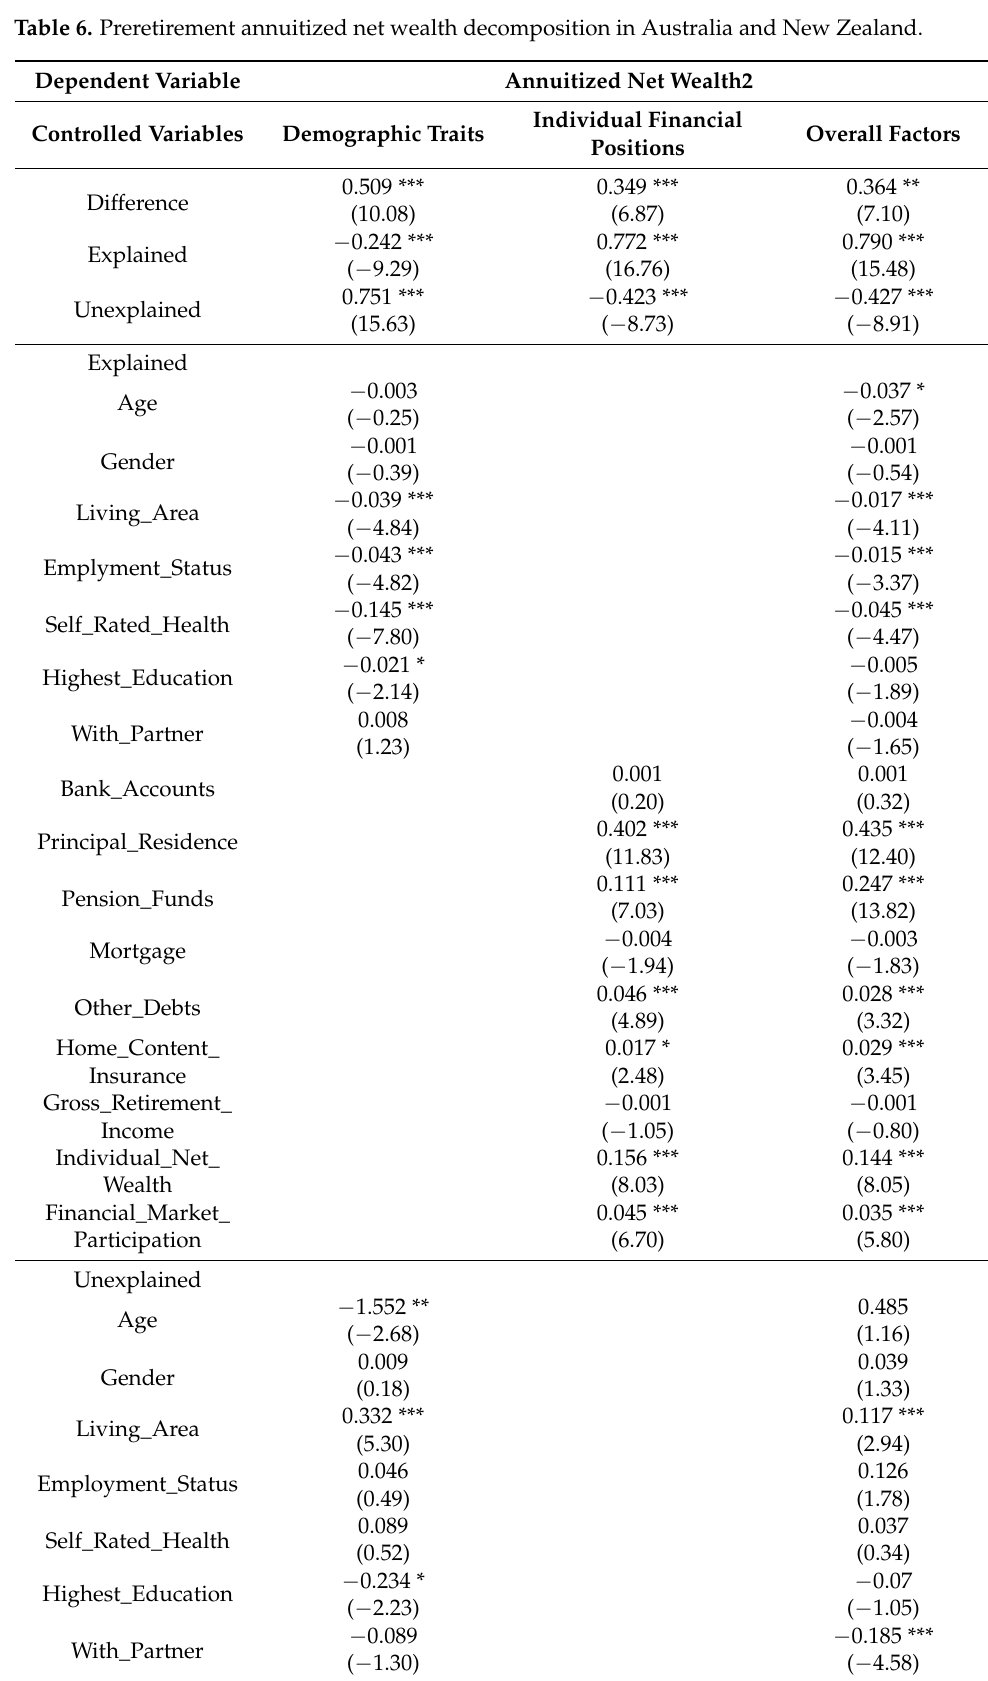
Table 6. Preretirement annuitized net wealth decomposition in Australia and New